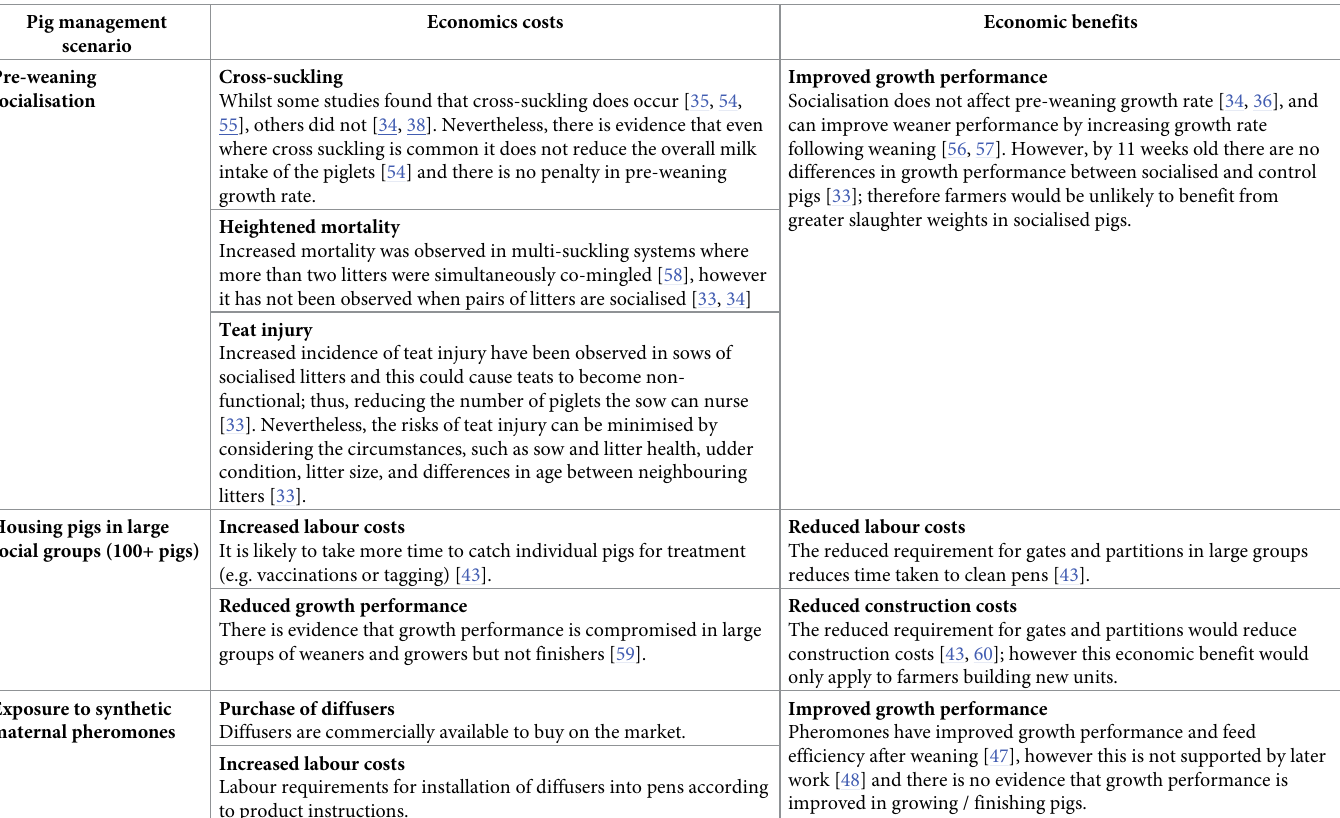
Table 5. Results of a review of the academic and industry literature investigating the economic costs and benefits likely to arise when implementing each aggression control strategy in practice. Pig management Economics costs Economic scenario